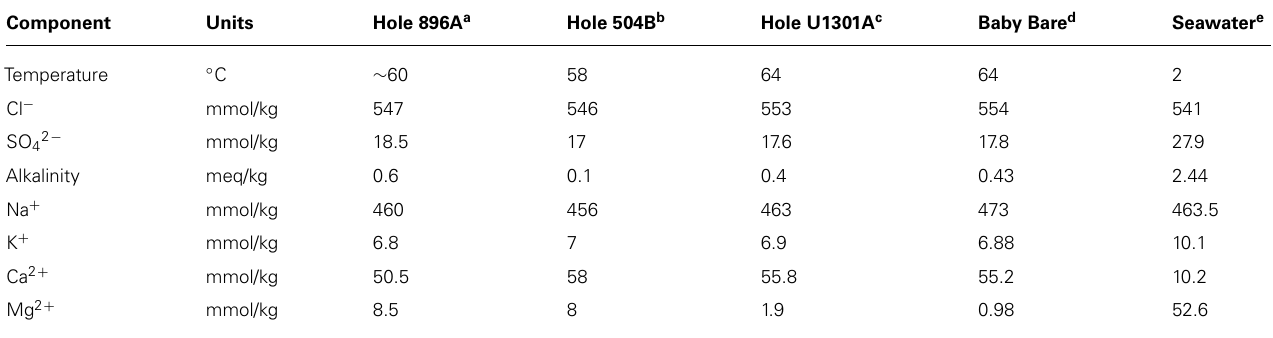
Table 1 | Comparative chemistry of fluids from Costa Rica Ridge flank Holes 896A and 504B with Juan de Fuca Ridge flank fluids, with seawater for comparison.